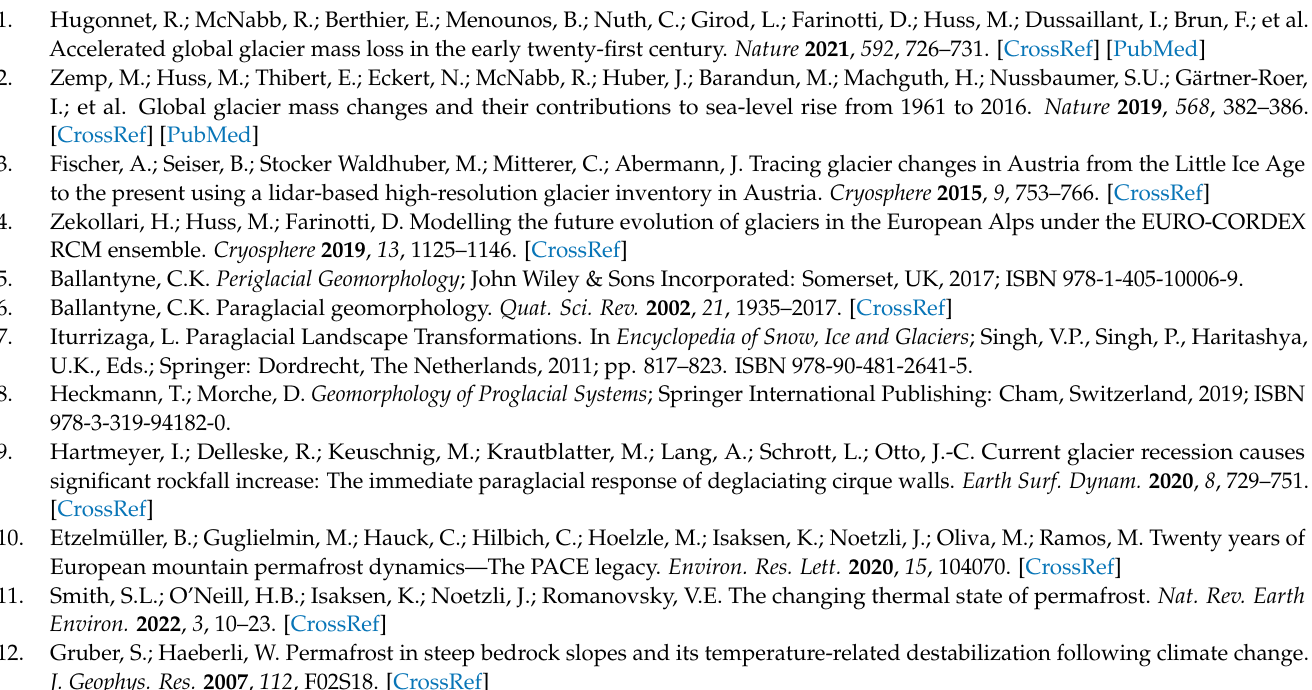
ELA.; Figure S2: Representation of the longitudinal profiles based on the DEM of 2006 for estimating the debris thickness.; Figure S3: Examples of further rockfalls from the headwalls of glaciers in the Eastern